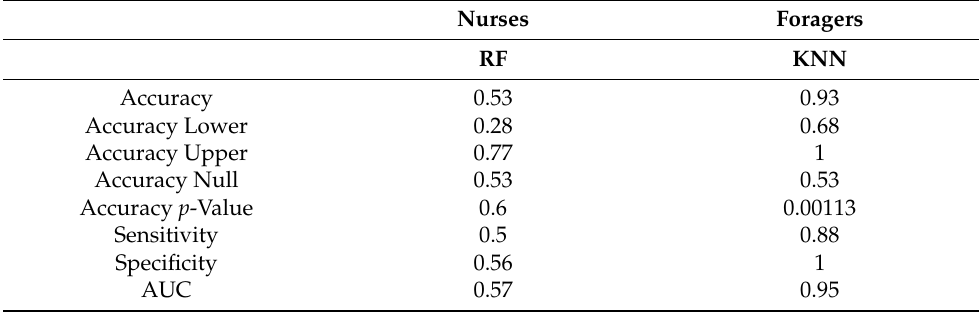
Table 2. Performances of the selected model on the test